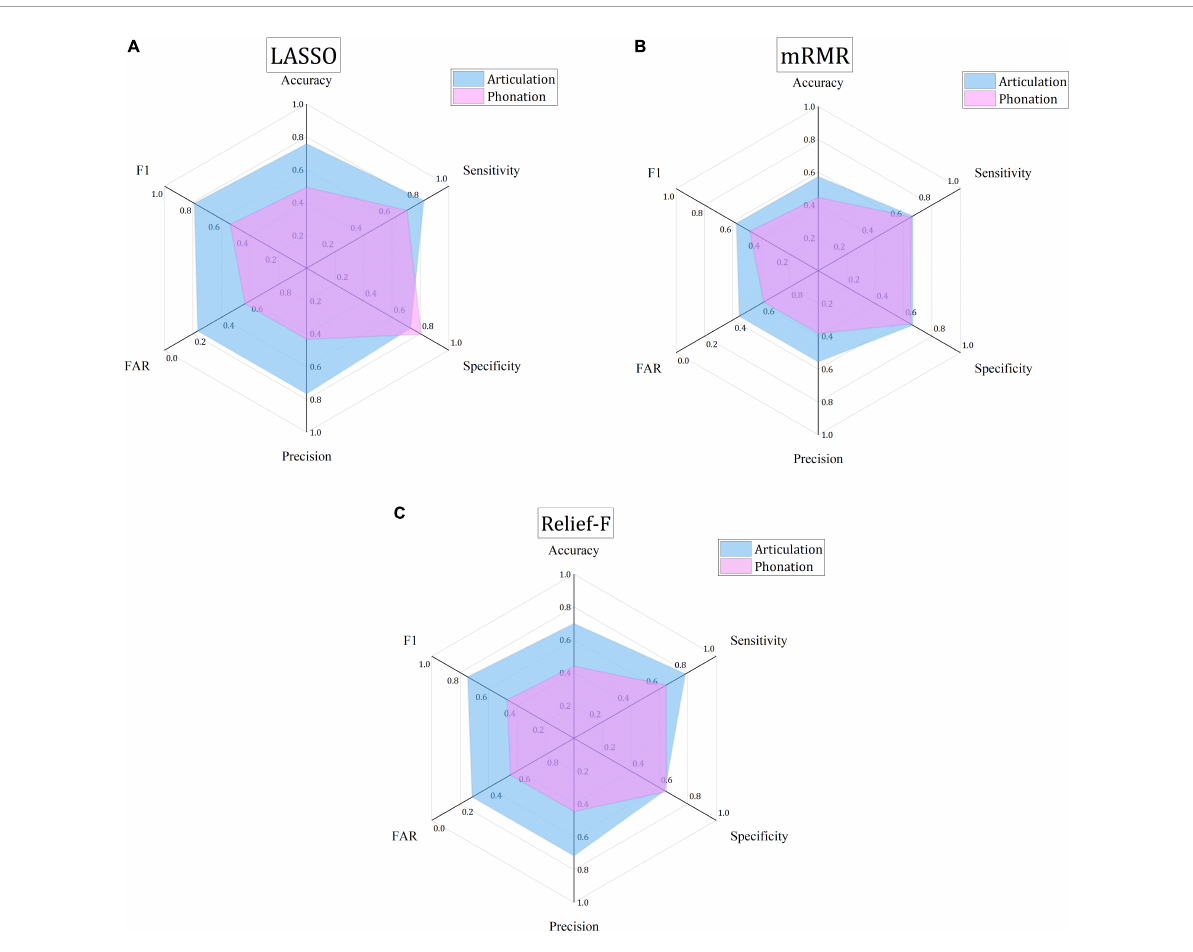
FIGURE4 Comparison of the best classification performances based on three FS algorithms and two types of features. (A) The best classification performance based on LASSO algorithm. (B) The best classification performance based on mRMR algorithm. (C) The best classification performance based on Relief-F